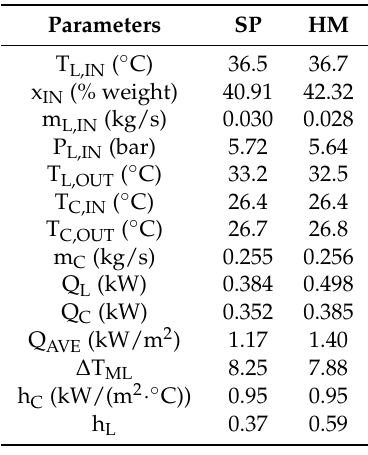
Table 3. Experimental results without absorption.